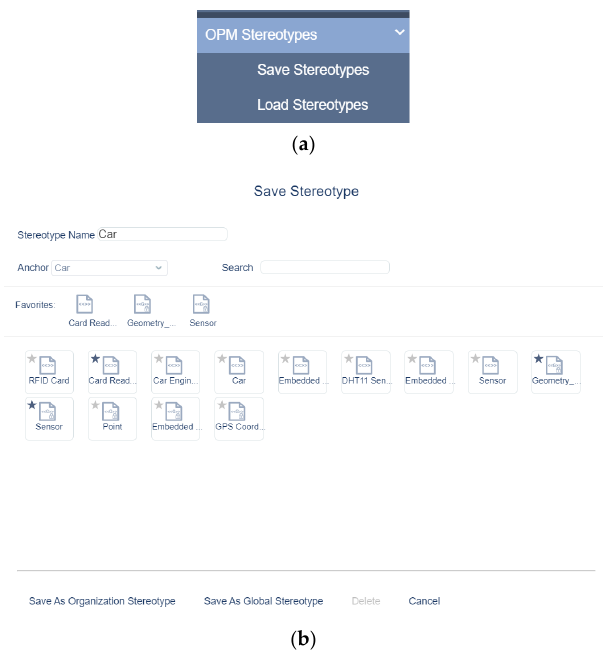
Figure 4. The Save Stereotype menu for OPCloud admins. ( a ) OPCloud main menu OPM Stereotypes options. ( b ) the Save Stereotype screen.